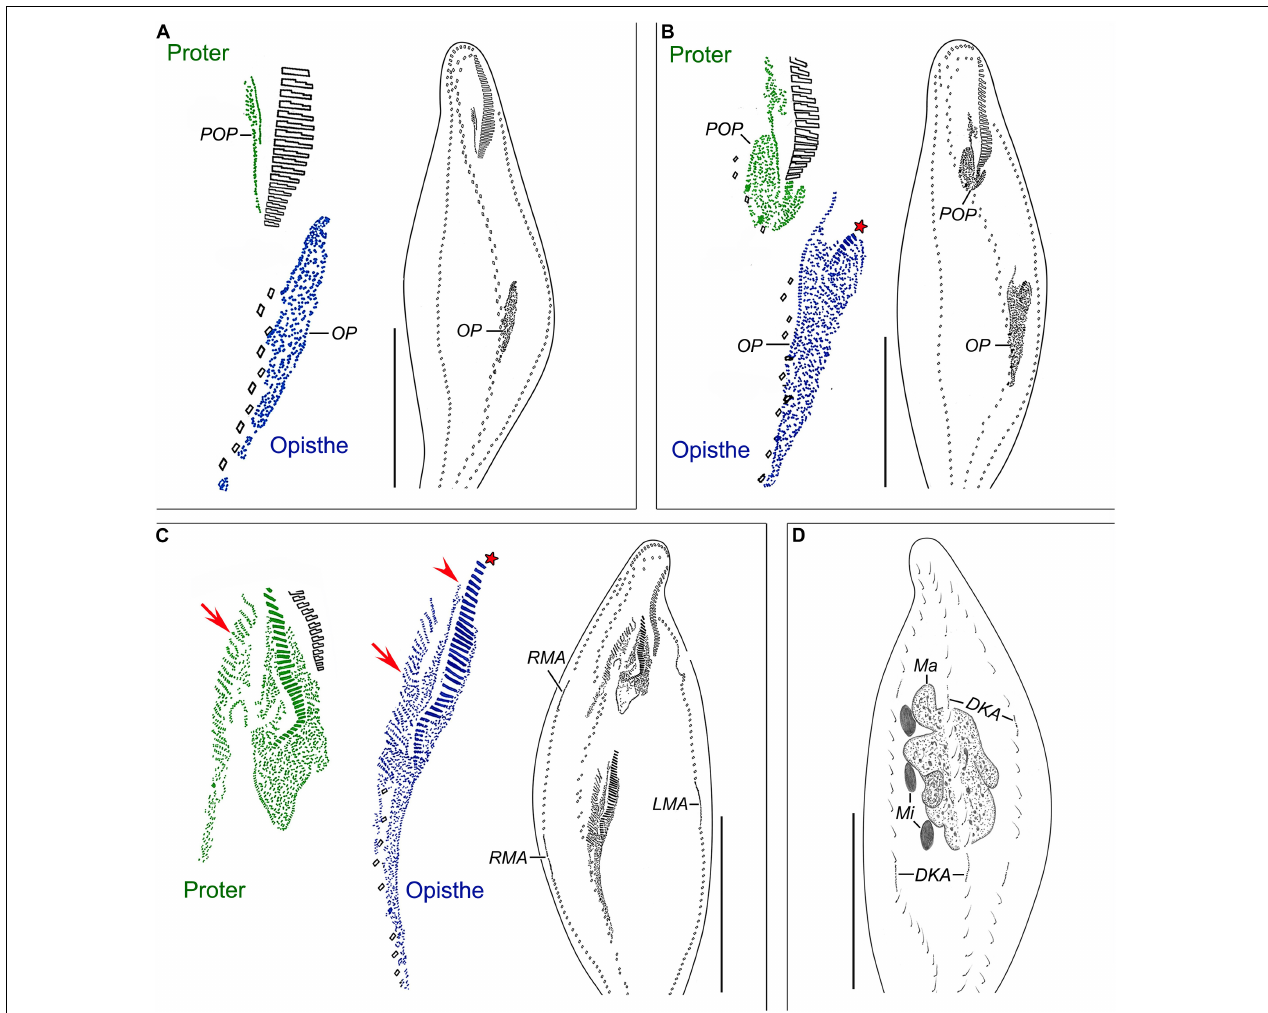
FIGURE 3 | Nothoholosticha luporinii n. sp., early dividers (A,B) and a mid-divider (C,D) after protargol impregnation. Magnified details of the proter’s ciliature are in green colour, while those of the opisthe’s ciliature are in blue colour. (A) Ventral view of an early divider, showing the formation of oral primordia in the proter and the opisthe. (B) Ventral view of another early divider, whose opisthe’s oral primordium begins to differentiate into adoral membranelles (red asterisk). (C,D) Ventral (C) and dorsal (D) views of the same early mid-divider. Arrows indicate formation of frontal-ventral–transverse cirral anlagen, arrowhead marks the undulating membranes anlage, asterisk denotes the newly formed adoral membranelles from the opisthe’s oral primordium. DKA, dorsal kineties anlagen; LMA, left marginal cirral row anlagen; Ma, macronuclear mass; Mi, micronuclei; OP, opisthe’s oral primordium; POP, proter’s oral primordium; RMA, right marginal cirral row anlagen. Scale bars = 120 µ